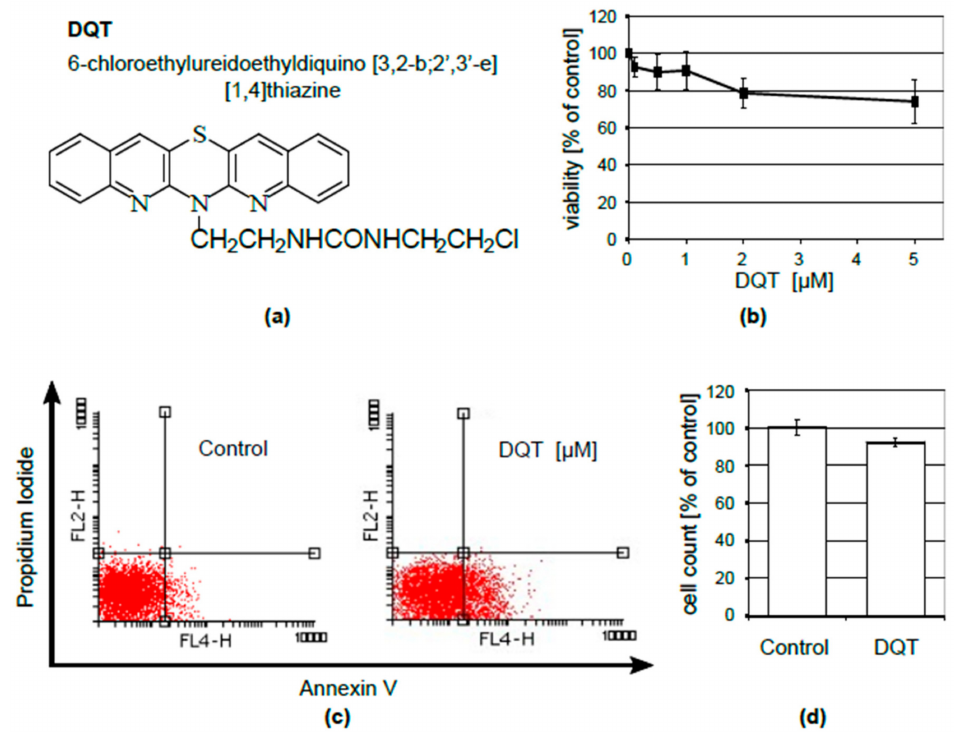
Figure 1. 6-Chloroethylureidoethyldiquino(3,2-b;2 (cid:48) ,3 (cid:48) -e)(1,4)thiazine (DQT) compound has negligible toxicity to KERTr cells. ( a ) Chemical structure of the azaphenothiazine derivative, DQT. ( b ) Viability of KERTr cells treated with DQT for 24 h, tested by the MTS assay. The results are presented as a percentage of the untreated control. Mean values and standard deviations of five independent experiments are shown. ( c ) Representative dot plots of Annexin V and propidium iodide staining of KERTr cells treated with 5 µ M DQT for 24 h; the percentage of Annexin V-positive cells (early apoptosis) is shown. ( d ) Cell counts after 24-h treatment of KERTr cells with 5 µ M of DQT; the results are presented as a percentage of the untreated control; mean values of three independent counts are